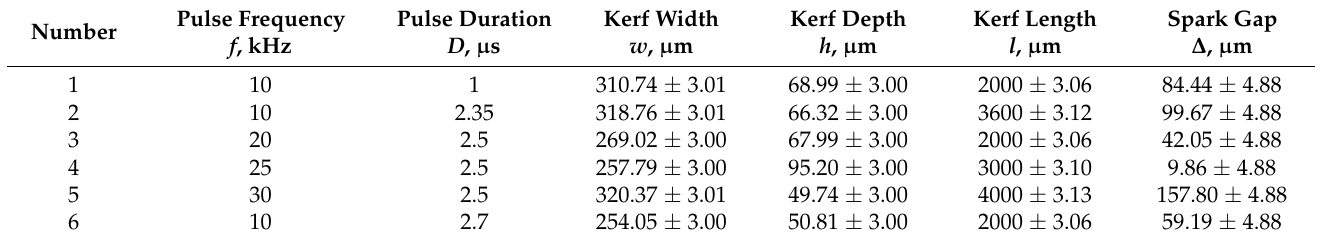
Table 11. The average measured kerf parameters for each factor-set and discharge gap of the machined alumina using a 12 µ m thick Ni-Cr coating and SnO-suspension (150 g/L).